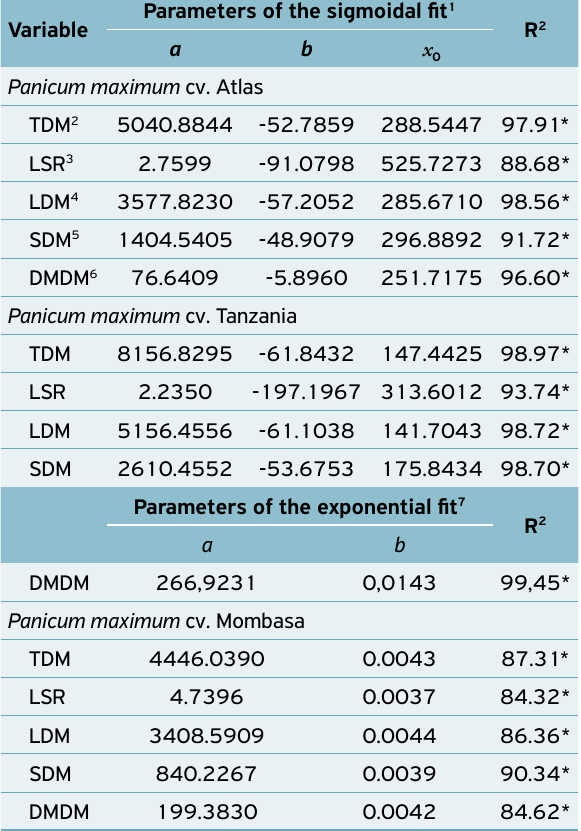
Table 2. Parameters of the regression equations obtained by fitting the sigmoidal and exponential models and coefficient of determination (R 2 ) applied to the means of total dry matter (kg ha -1 ), leaf to stem ratio, leaf dry matter (kg ha -1 ), stem dry matter (kg ha -1 ), and dead material dry matter (kg ha -1 ) in the cultivation of Panicum maximum cv. Atlas, P. maximum cv. Tanzania, and P. maximum cv. Mombasa at 80 days after sowing (DAS) as a function of glyphosate doses (0, 54, 108, 270, 378, 540, 756, and 1,080 g a.e. ha -1 ) associated with atrazine (1,200 g a.i. ha -1 ).